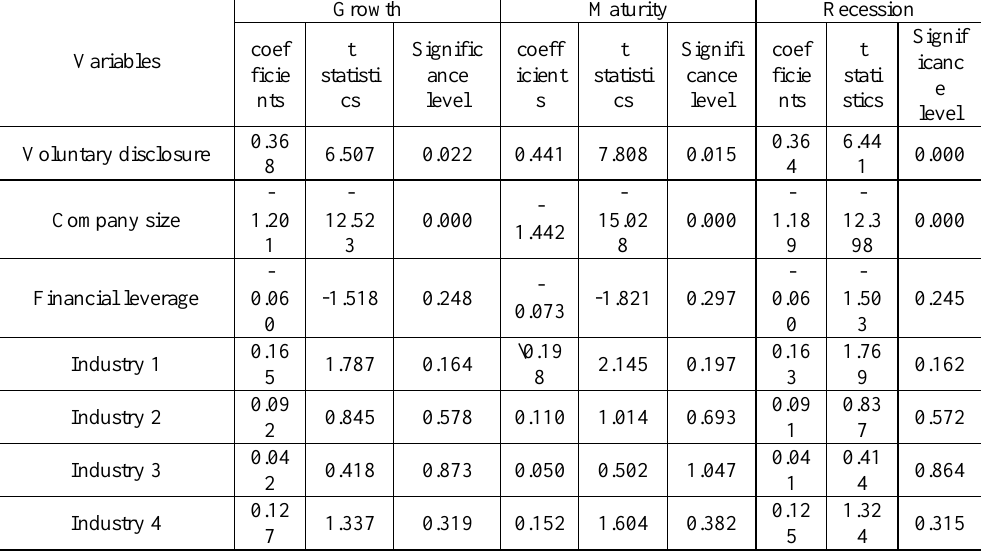
Table 5. Results of testing the relationship between voluntary disclosure and